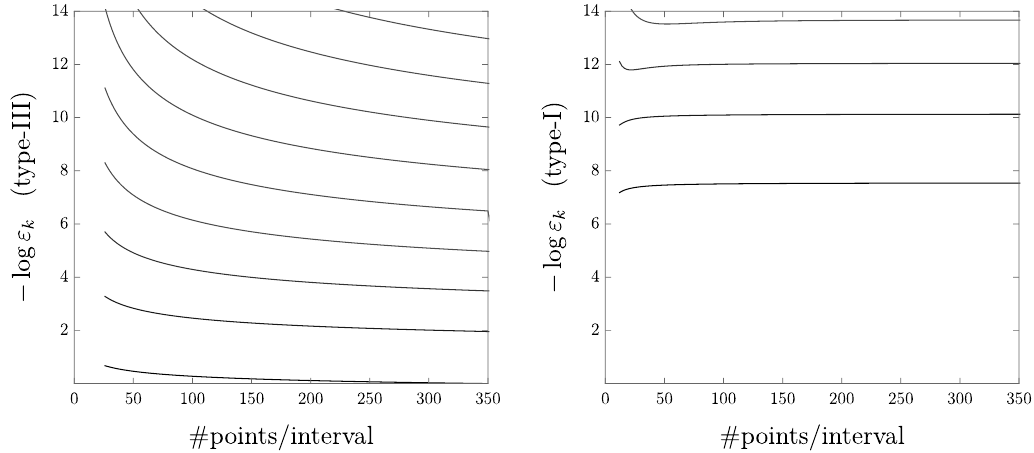
Figure 3 . We plot the “leading” eigenvalues of the correlator matrices V A and V AA ∗ involved in the evaluation of: the usual type-III entanglement entropy for a single interval (left); the reflected entropy R ( A, B ) for two invervals A , B with cross-ratio η = 1 / 4 (right). For both plots, the horizontal axis corresponds to the number of points taken for the intervals ( A in the first case and both A and B in the second). In both cases, we use a logarithmic function of the eigenvalues which simplifies presentation of several eigenvalues in the same plot — see eq.